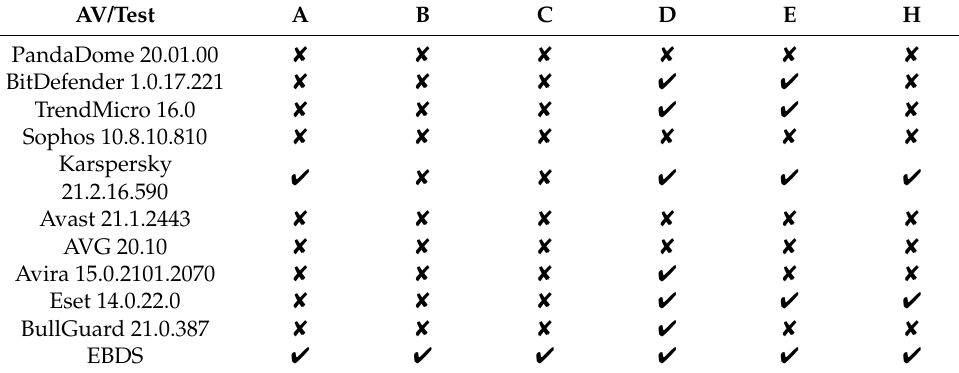
Table 4. Execution of malicious code modified by applying string substitution.